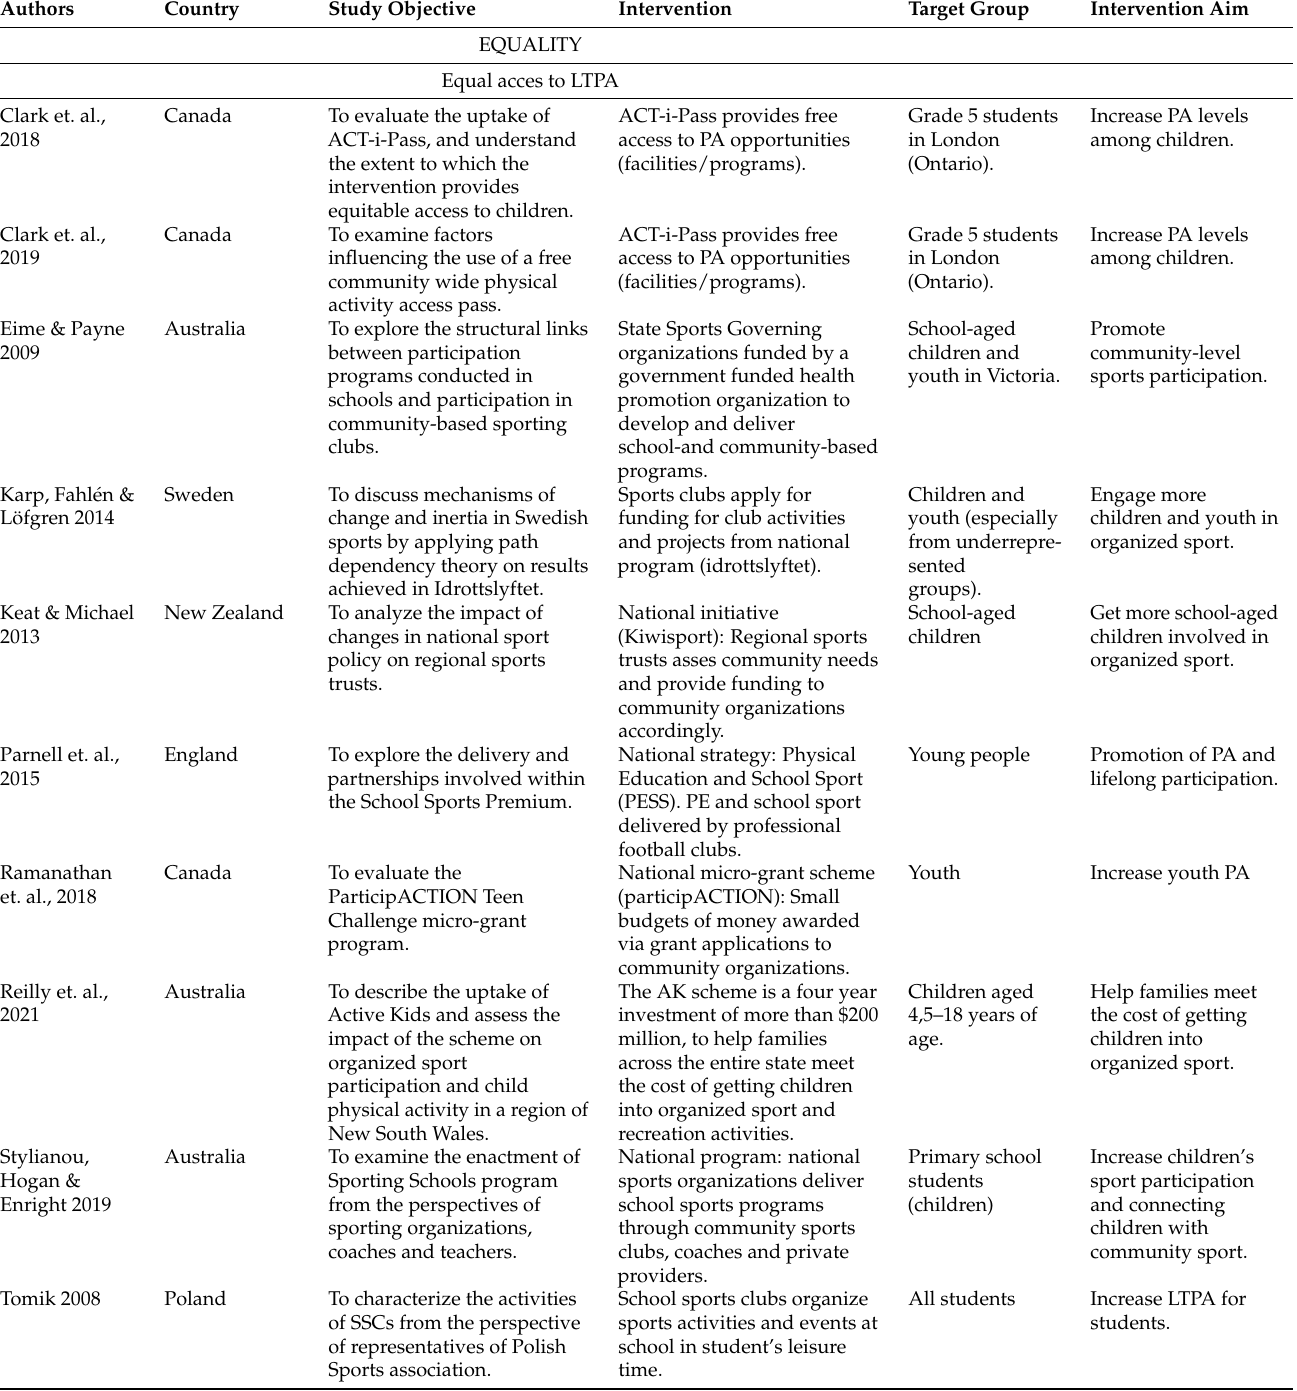
Table 2. Data extraction chart: Summary of Study objective, intervention characteristics, target group and